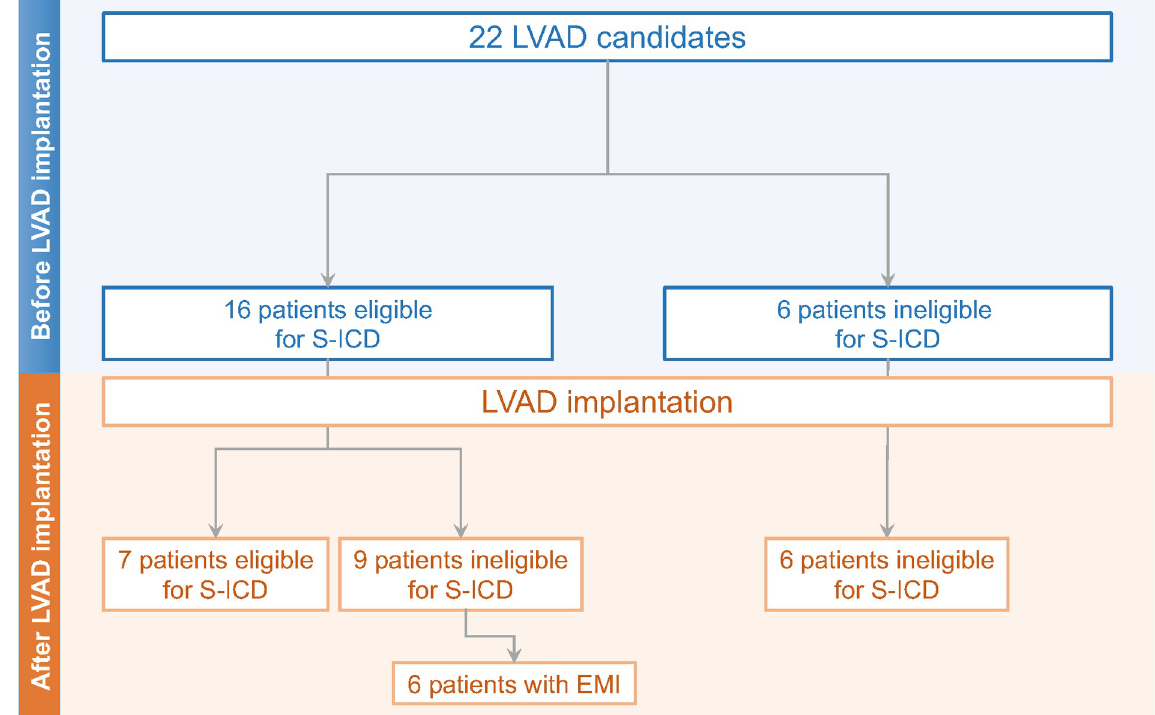
Fig 3. Evolution of S-ICD eligibility before and after LVAD implantation. LVAD = left ventricular assist device; S-ICD = subcutaneous implantable cardioverter-defibrillator; EMI = electromagnetic interference.